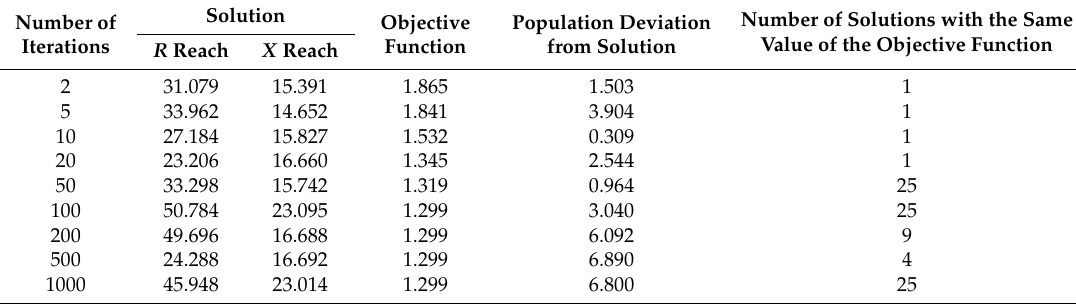
Number of Solutions with the Same Value of the Objective Function R